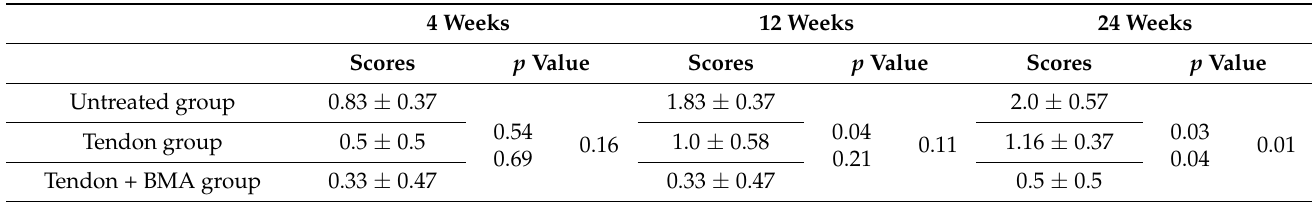
Table 1. Macroscopic scores based on ICRS scoring system